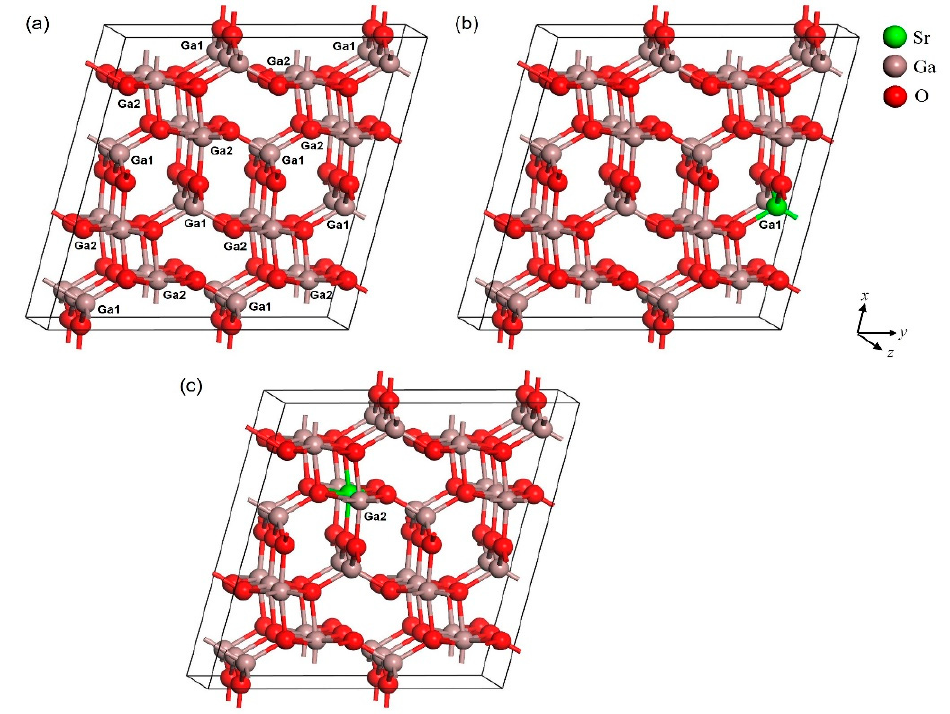
Figure 2. Crystal structure of 1 × 2 × 2 supercell of ( a ) pure β -Ga 2 O 3 , ( b ) Sr-doped β - Ga 2 O 3 at Ga1, and ( c ) Sr-doped Ga 2 O 3 at Ga2.